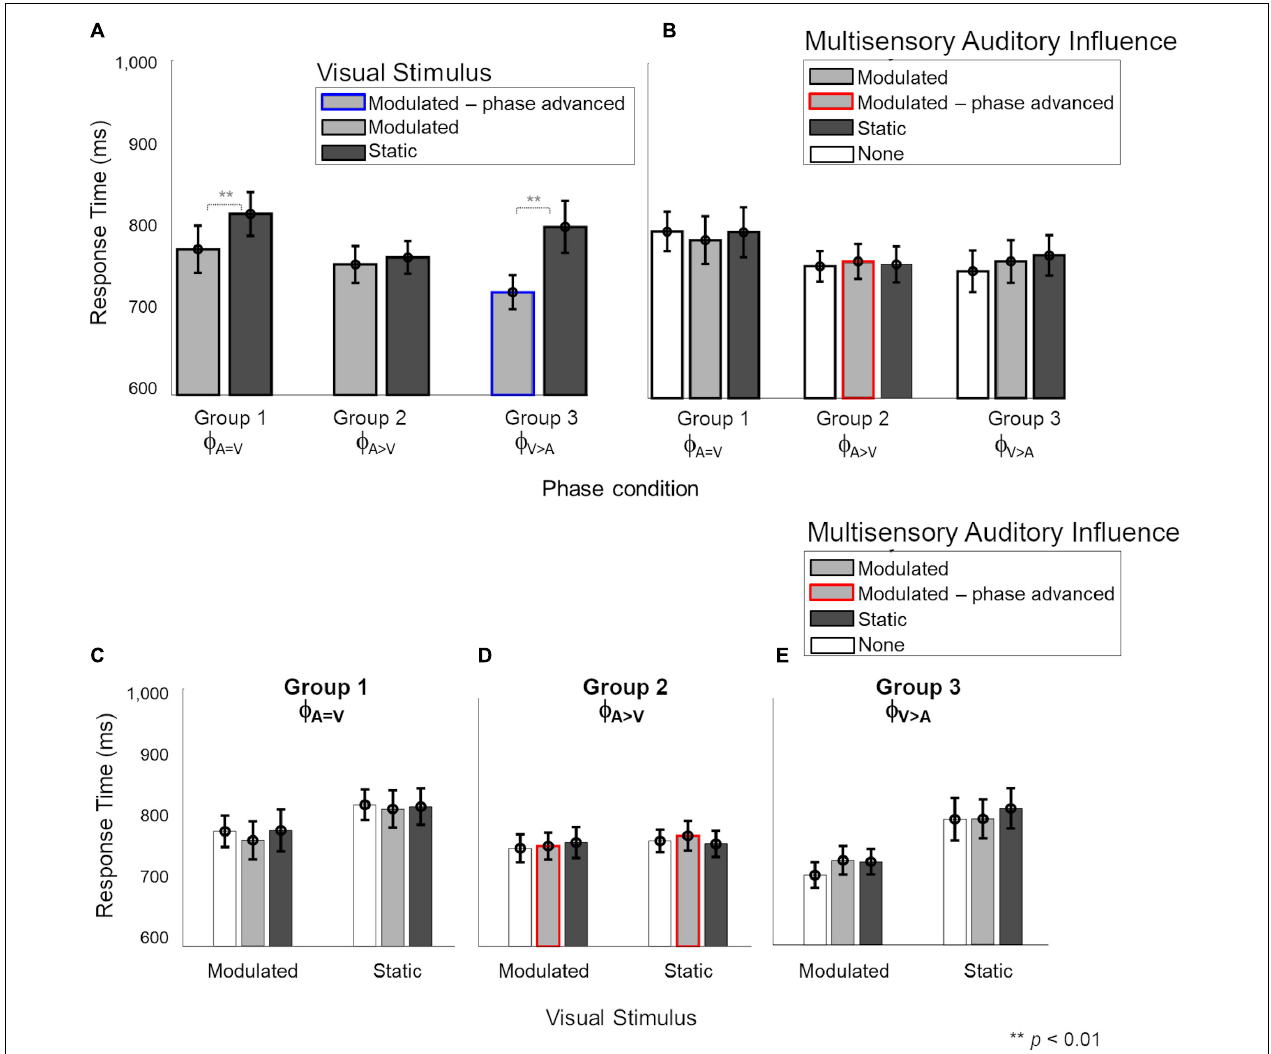
FIGURE 5 | Response times during the multisensory visual task. In panels (B–E) , light and dark gray bars show the presence of barely-delectable modulated and static auditory influences, respectively, while white bars show the unisensory condition. Red and blue lines indicate phase-advanced auditory and visual conditions, respectively. (A) There was a significant main effect of “Visual stimulus” (2 levels: modulated – static) where responses for modulated stimuli were faster than static stimuli for phase conditions φ A = V and φ V > A . There was no main effect of “Auditory influence” (3 levels: none – modulated – static). (B) Nor any significant interaction between the auditory stimulus and visual influence for any phase conditions (C–E) . Error bars represent ± 1